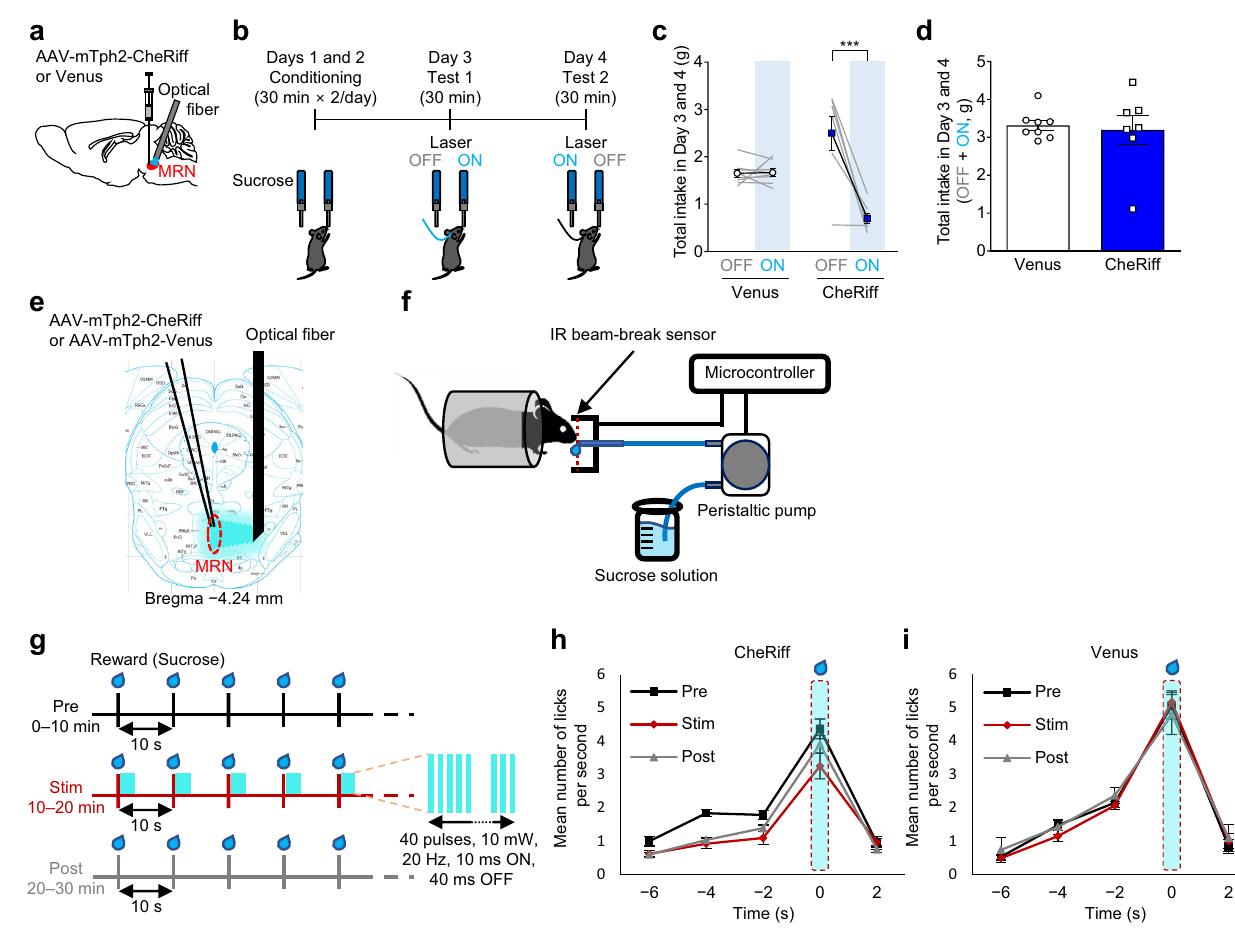
Fig. 3 | Effect with activation of MRN serotonergic neurons on reward con- sumption. a Schematic representation of AAV injection and fi ber implantation. b Two-bottle choice test. The position of the bottle paired with light was counter- balanced between days 3 and 4. c Total intake of sucrose solution in each bottle. Two-way repeated-measures ANOVA with Sidak post hoc test, virus×light interac- tion F 1,13 =26.97, P =0.0002, virus F 1,13 =0.09712, P =0.7603, light F 1,13 =26.01, P =0.0002; posthoc test:ValuedconditionOFF-CheRiff vsON-CheRiff*** P <0.001, n =8 (Venus) and 7 (CheRiff)mice). d Total intake of solutionfrom both ofbottles. Two-tailed unpaired t -test with Welch ’ s correction, t 7.378 =0.2949, P =0.7762, n =8 (Venus)and7(CheRiff)mice. e SchematicrepresentationofAAVinjectionand fi ber implantationanddistancefromthebregma. f Head- fi xedsetup.Miceweresecured by head clamps attached to the chamber frame. A 10% sucrose reward was